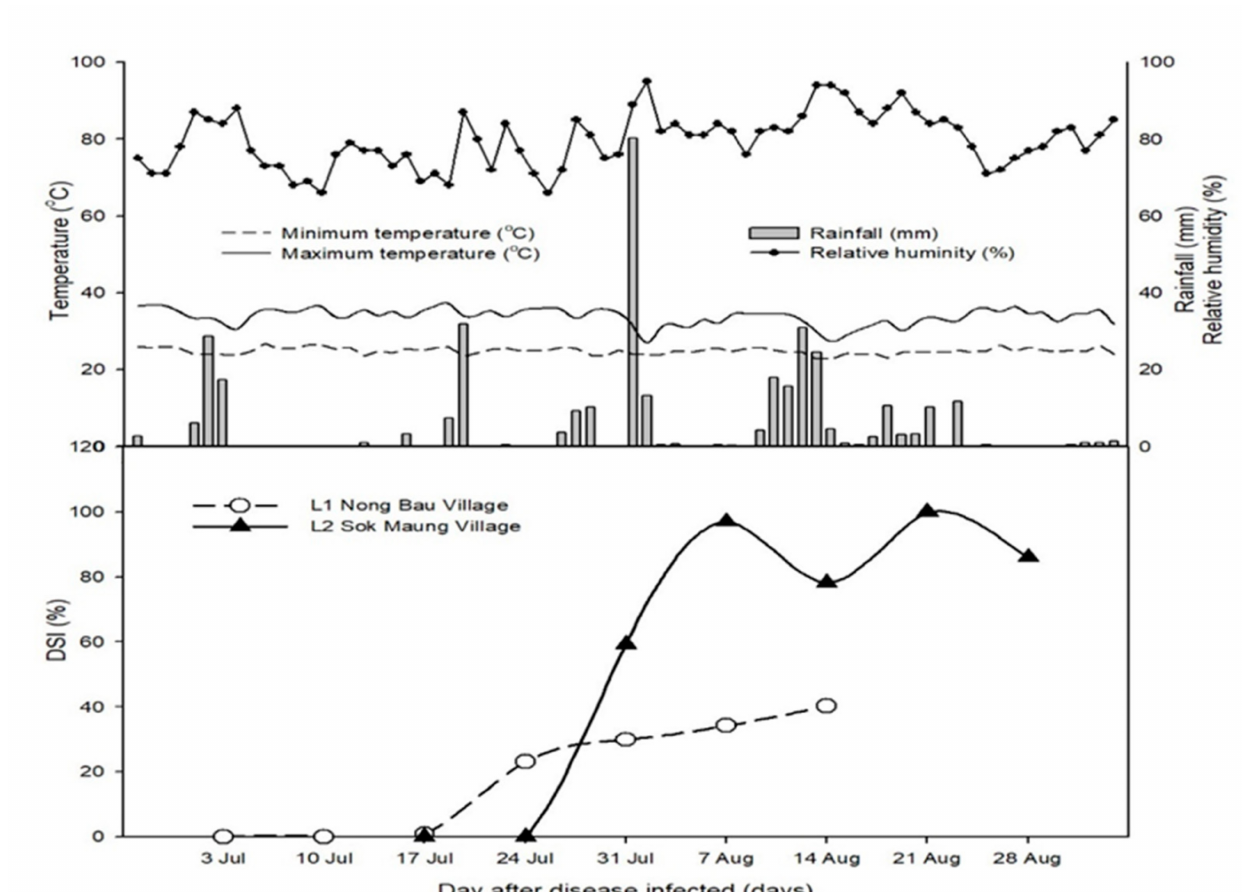
Figure 4. Disease severity index (%) of downy mildew in 50 small-ear waxy corn varieties at 2 locations (Nong Bau Village and Sok Maung Village), start from 3rd June 2020 until 28th August 2020, and temperature, rainfall and relative humidity at Banphang, Khon